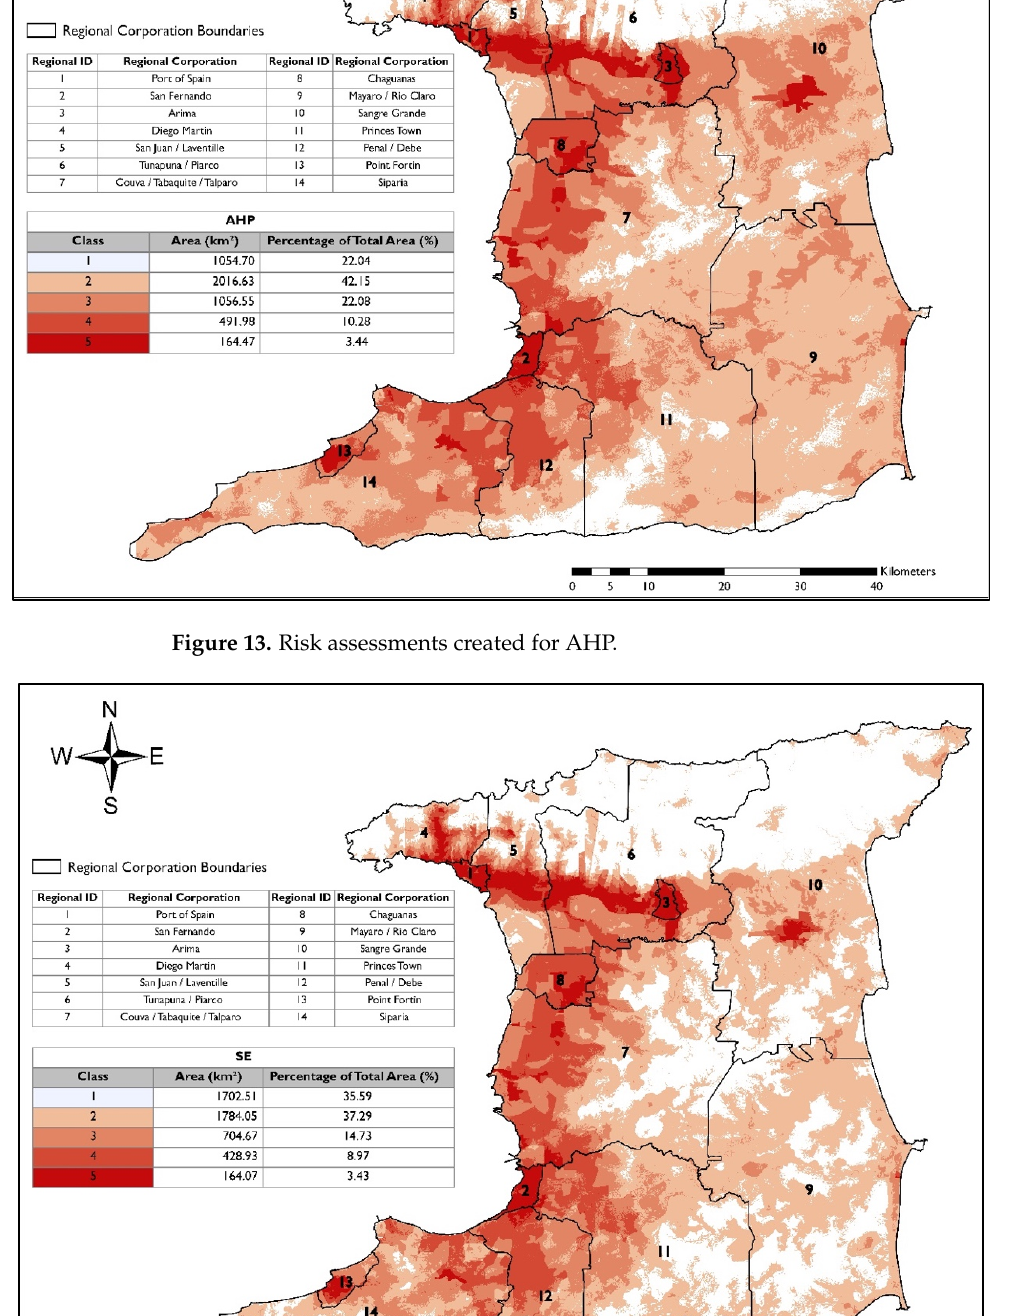
Figure 15. Risk assessments created for SE.